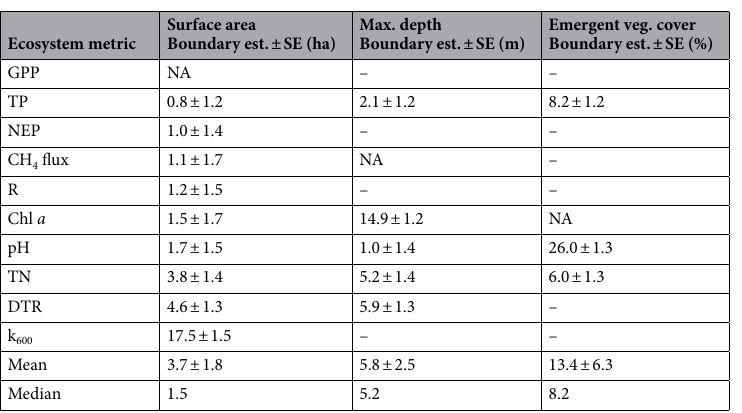
Table 1. Nonlinear boundary values, parameter estimate ± standard error (SE), from comparisons between surface area, maximum (max.) depth, and emergent vegetation (veg.) cover and ecosystem structure/function metrics including gross primary production (GPP), total phosphorus concentrations (TP), methane fluxes (CH 4 flux), respiration (R), net ecosystem production (NEP), chlorophyll a concentrations (Chl a ), pH, total nitrogen concentrations (TN), diel temperature ranges (DTR), and gas transfer piston velocity (k 600 ). Boundary estimates are included if the nonlinear models (segmented regression or logistic relationships) were selected as optimal fits with standard error as determined when fitting the parameter. NA indicates a null or linear fit, – indicates not enough data was available to perform the